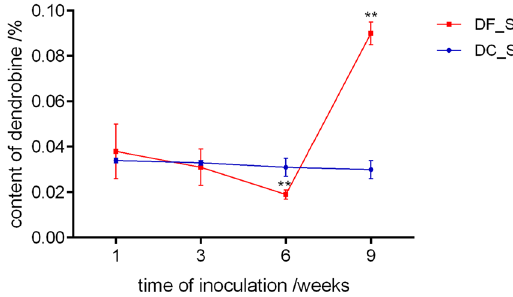
Figure 2. The effect of MF23 on the dendrobine content in D. nobile tissue culture seedlings. Values are presented as the means ± SD (n = 3); values with ** are of statistical significance at P <